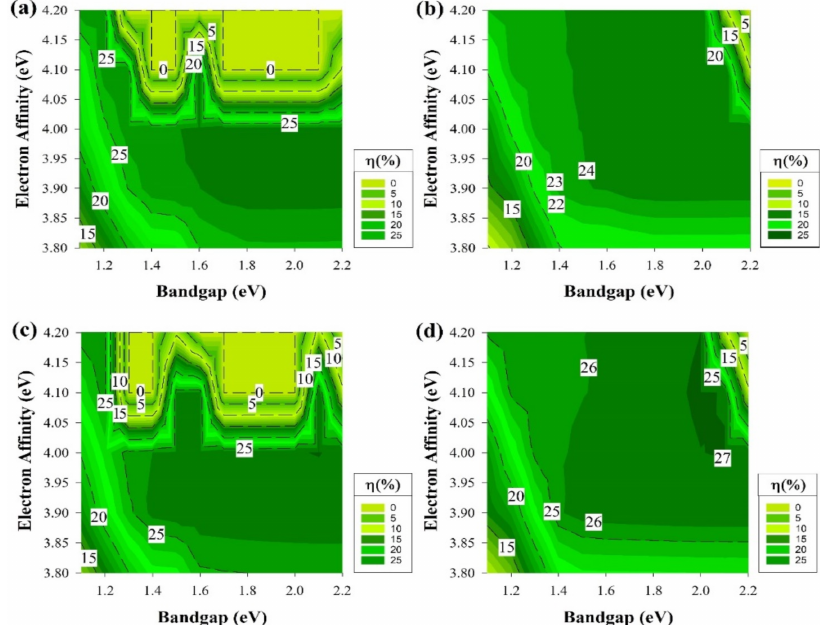
Figure 12. The efficiency of four proposed structures, including a-Si:H passivating layers as a function of Eg and χ for doped layers with defects at the 0.2 eV level below Ec. ( a ) Contour graphs of the n-i-p structure with p-type wafer base. ( b ) Contour graphs of the n-i-p structure with n-type wafer base. ( c ) Contour graphs of the p-i-n structure with the p-type wafer. ( d ) Contour graphs of the p-i-n structure with n-type wafer